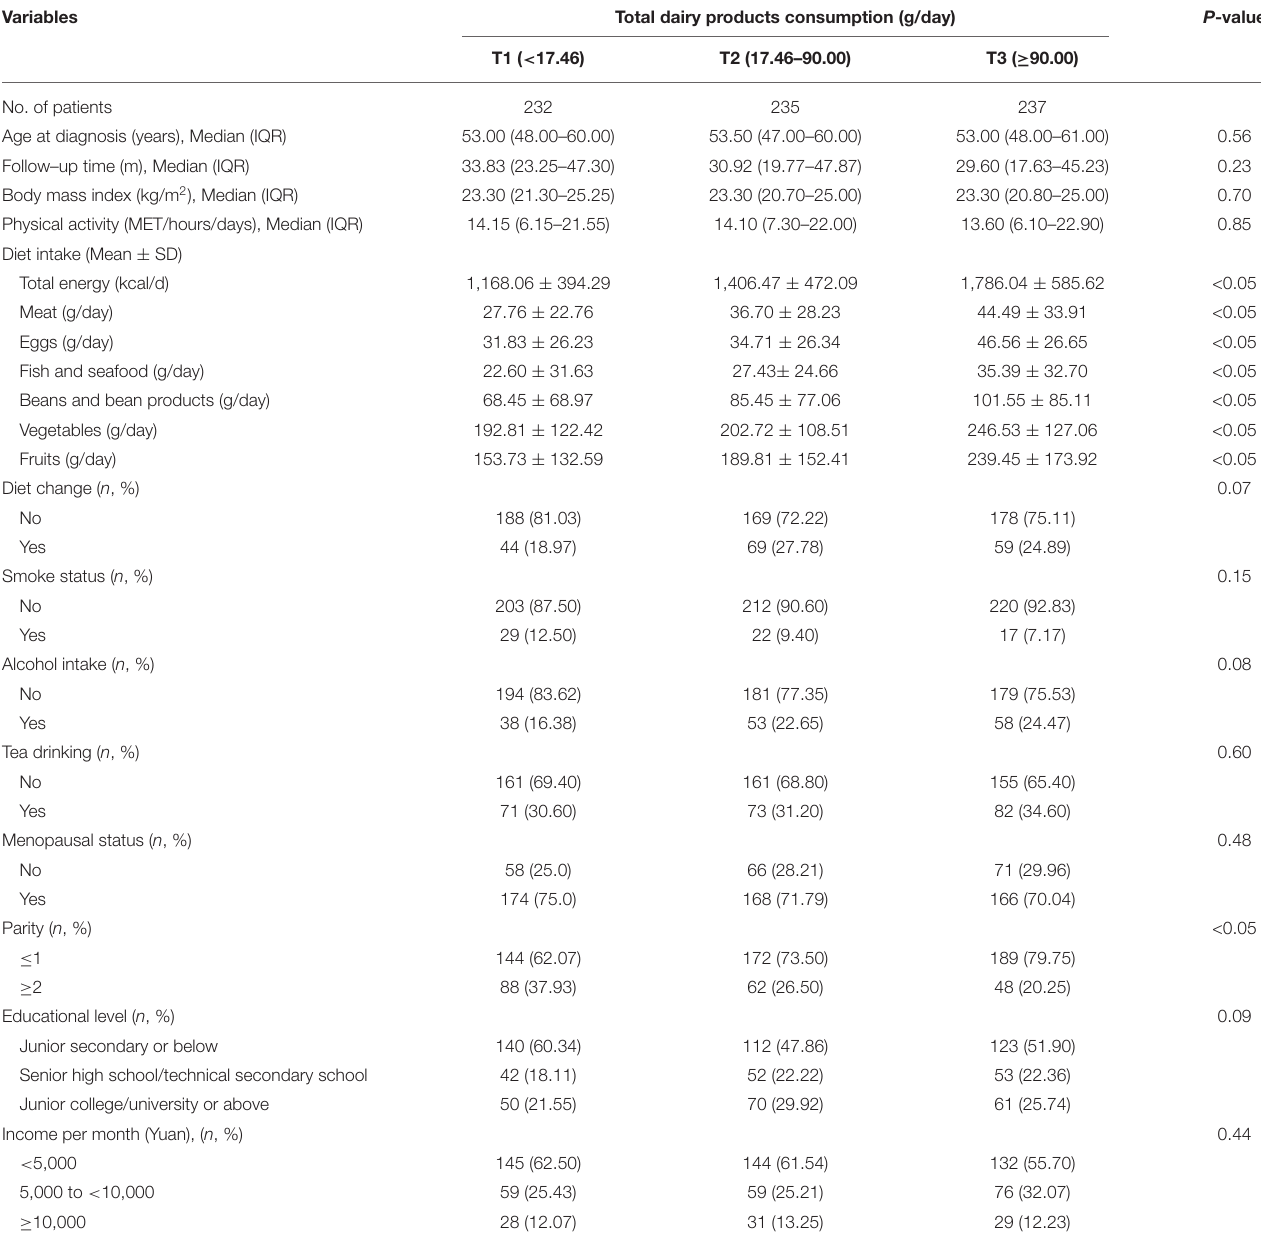
TABLE 1 | General characteristics of ovarian cancer patients according to dairy products ( N = 703).